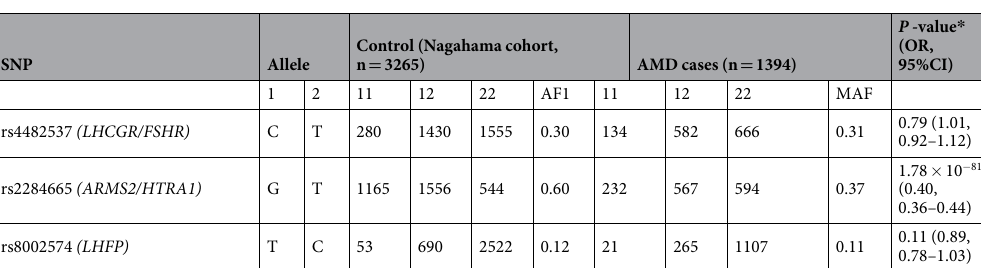
Control (Nagahama cohort, n = 3265)